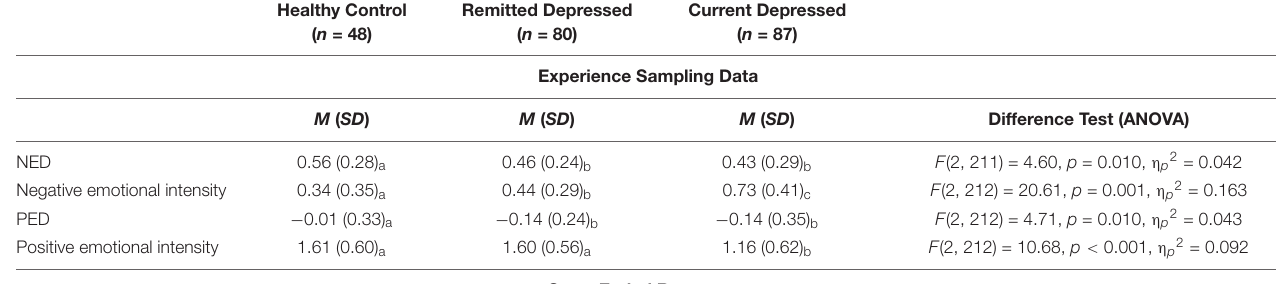
TABLE 2 | Emotion differentiation, emotional intensity, and open-ended responses of emotional experience by group. Healthy Control ( n =